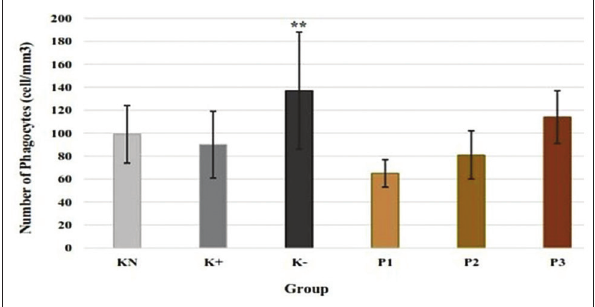
KN=Normal control, K+=Positive control, K−=Negative control, P1=Administration of PS before infection, P2=Administration of PS after infection, P3=Administration of PS before and after infection, values are represented as means±SD (n=6). **p<0.05 compared to KN group, ***p<0.05 compared to all groups, TNF=Tumor necrosis factor,